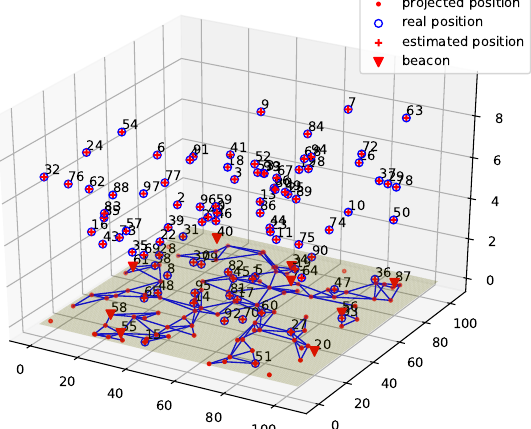
Figure 8. Gradient descent localization for the projected 50-node 5-beacon MUWSN on the beacon plane in E 2 .